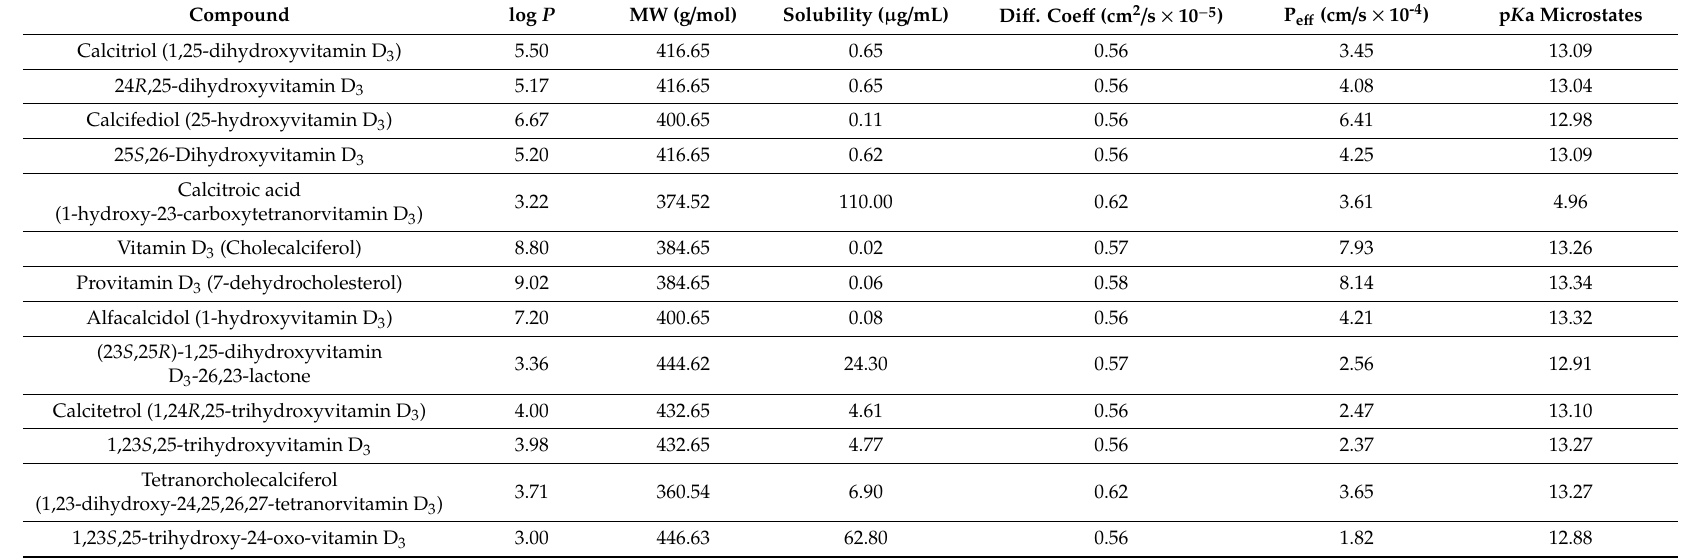
Table 1. Estimation of physicochemical properties of provitamin D 3 (precursor of vitamin D 3 ) and vitamin D 3 derivatives using GastroPlus software. Abbreviations: MW, molecular weight; Di ff . Coe ff , di ff usion coe ffi cient; P e ff , human jejunal e ff ective